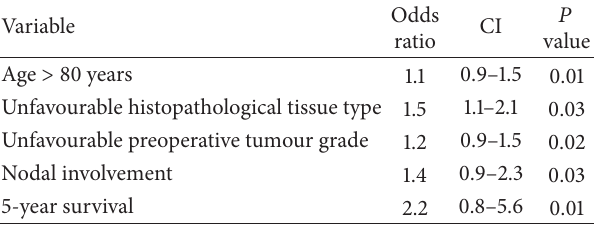
Table 2: Correlation with elevated CA125 ( > 28 U/mL).